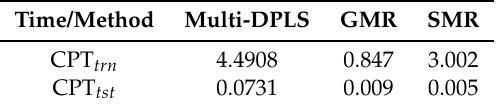
Table 5. Average CPT (in second) consumed by various methods for the primary reformer